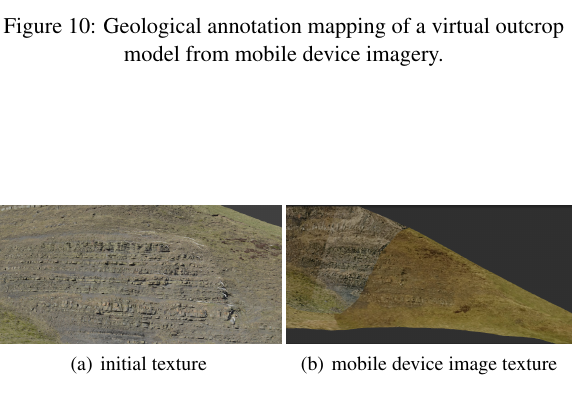
Figure 11: Re-texturing a textured model with mobile device (Nexus 5) image